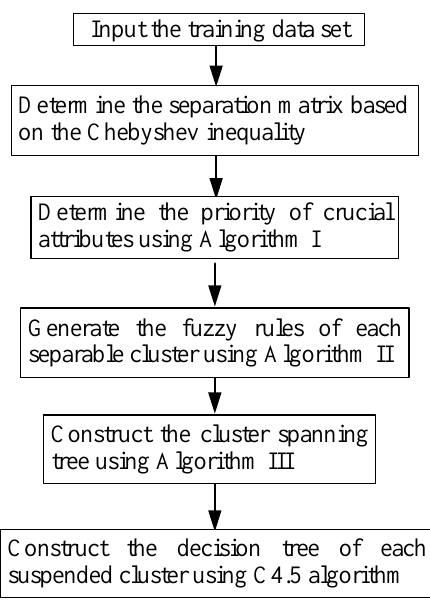
Figure 2. Flow diagram of the fuzzy logic clustering decision tree (FLCDT) scheme.